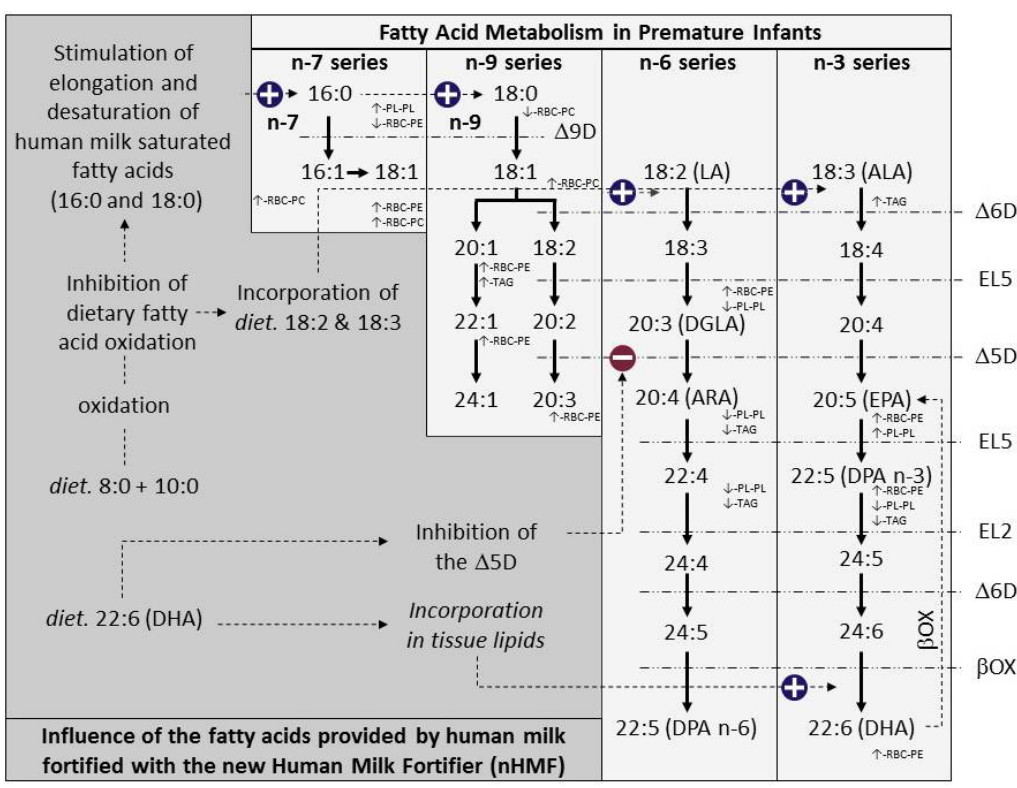
Figure 1. Schematic representation of the influence of dietary fatty acids provided by the nHMF. Differences (shown by the ↑ and ↓ symbols) between relative concentrations of FA provided by the nHMF or the cHMF in the compartments assessed are statistically significant ( p <0.05). Metabolic pathways responsible for the biosynthesis of FA from the n -3, n -6, n -7, and n -9 series are displayed together with the enzymes involved (Δ9D, Δ9-desaturase; Δ6D, Δ6-desaturase, EL5, elongase 5; Δ5D, Δ5-desaturase; EL2, elongase 2; βOX, β-oxidation).